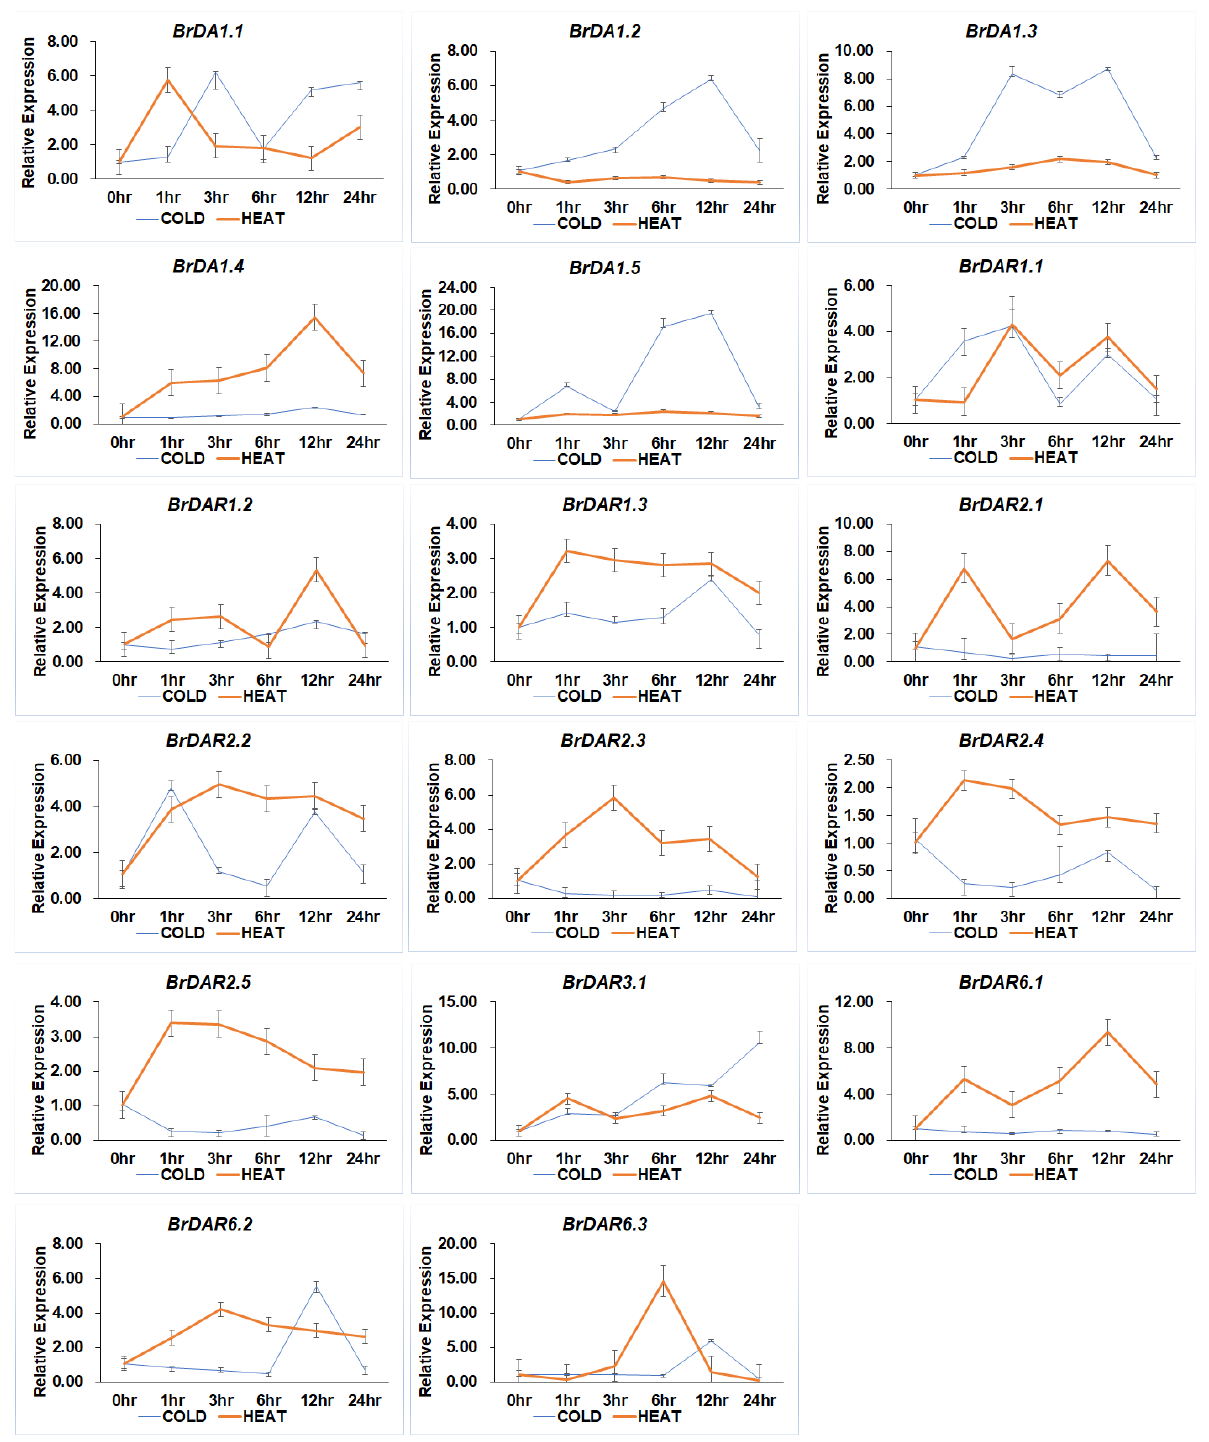
Figure 9. Relative expression patterns of BrDA1 & DAR genes under cold (4 °C) and high temperature (44 °C) treatment. Time points of 0h as CK, 1 h, 3 h, 6 h, 12 h, and 24 h displayed the sampling intervals.